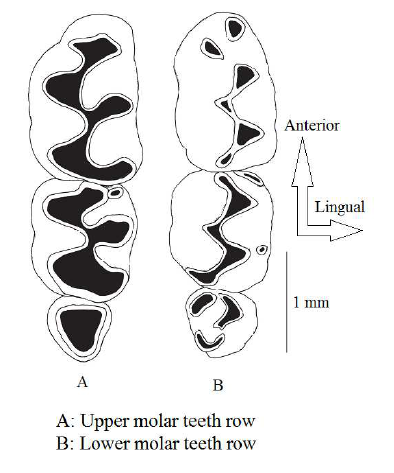
FIGURE 13 : Teeth rows in